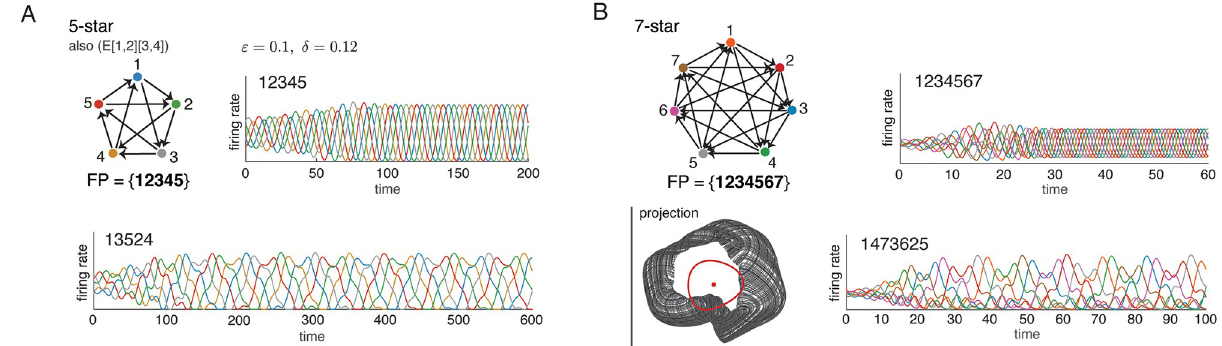
Fig 9. Symmetry can lead to spurious attractors. (A) Although the 5-star graph has only a single attractor in the standard CTLN parameters, for ε = 0.1, δ = 0.12 a second attractor emerges (bottom). Both can be accessed via small perturbations of the unique fixed point. (B) The 7-star graph also has two attractors that can be accessed from a single core fixed point, even in the standard parameters. The projection (bottom left) depicts a random projection of R 7 onto the plane, with trajectories for the limit cycle (red circle) and an additional quasiperiodic attractor (black torus). The fixed point is also shown (red